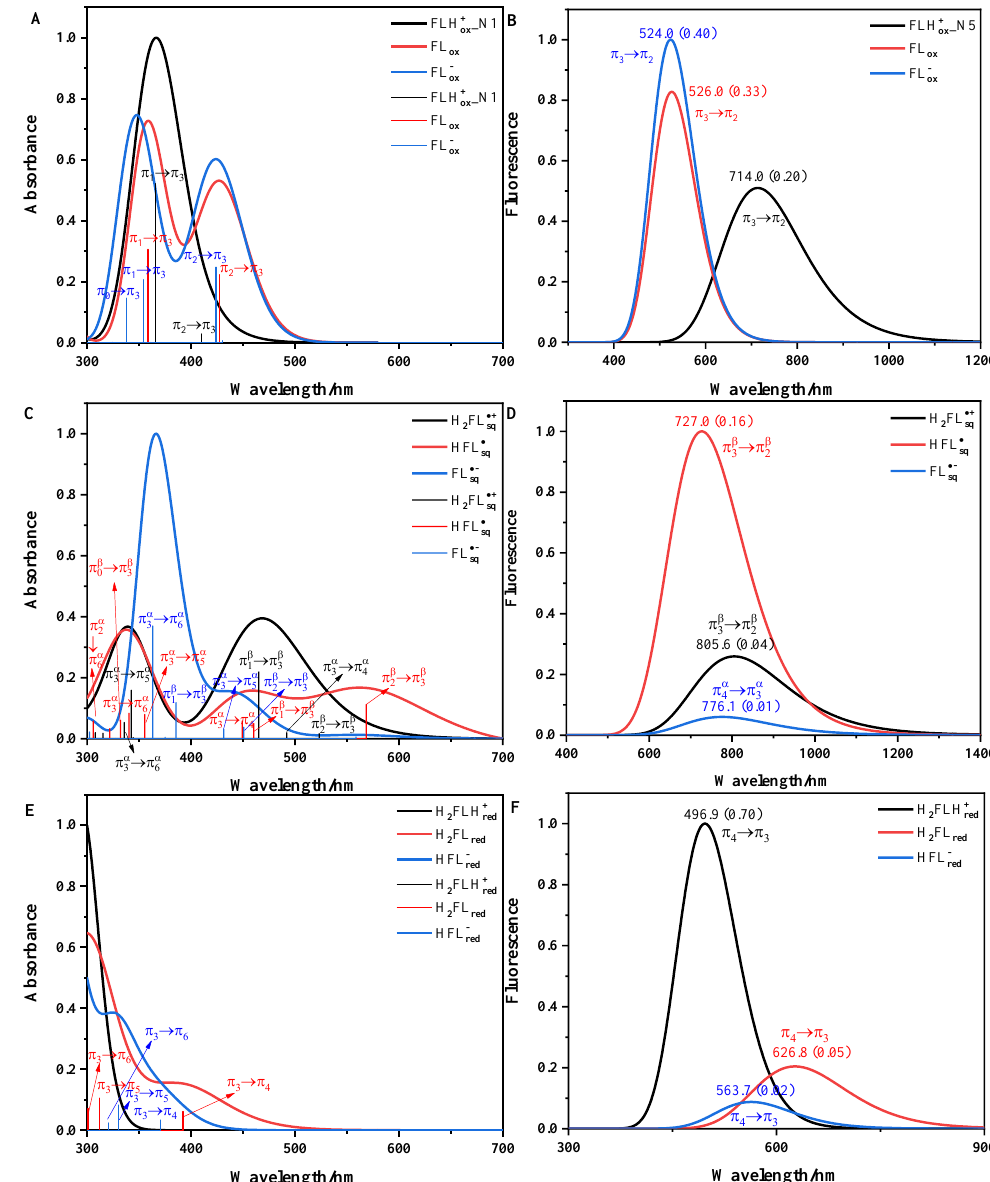
Figure 3. The computational absorption spectra ( A , C , E ) and fluorescence spectra ( B , D , F ) of flavin quinone, flavin semiquinone, and flavin hydroquinone in aqueous solution. Thin vertical lines represent the electronic excited states, with the corresponding transition analysis next to them. Values in parentheses represent the f of fluorescence spectra.